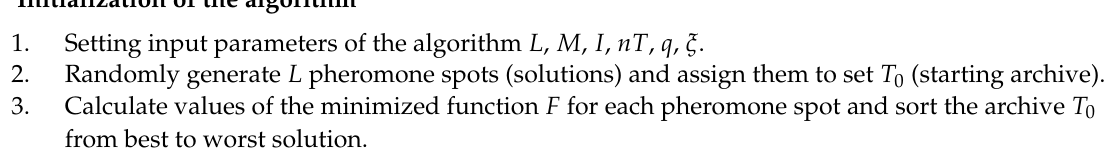
Algorithm 1: Parallel Real ACO algorithm Initialization of the